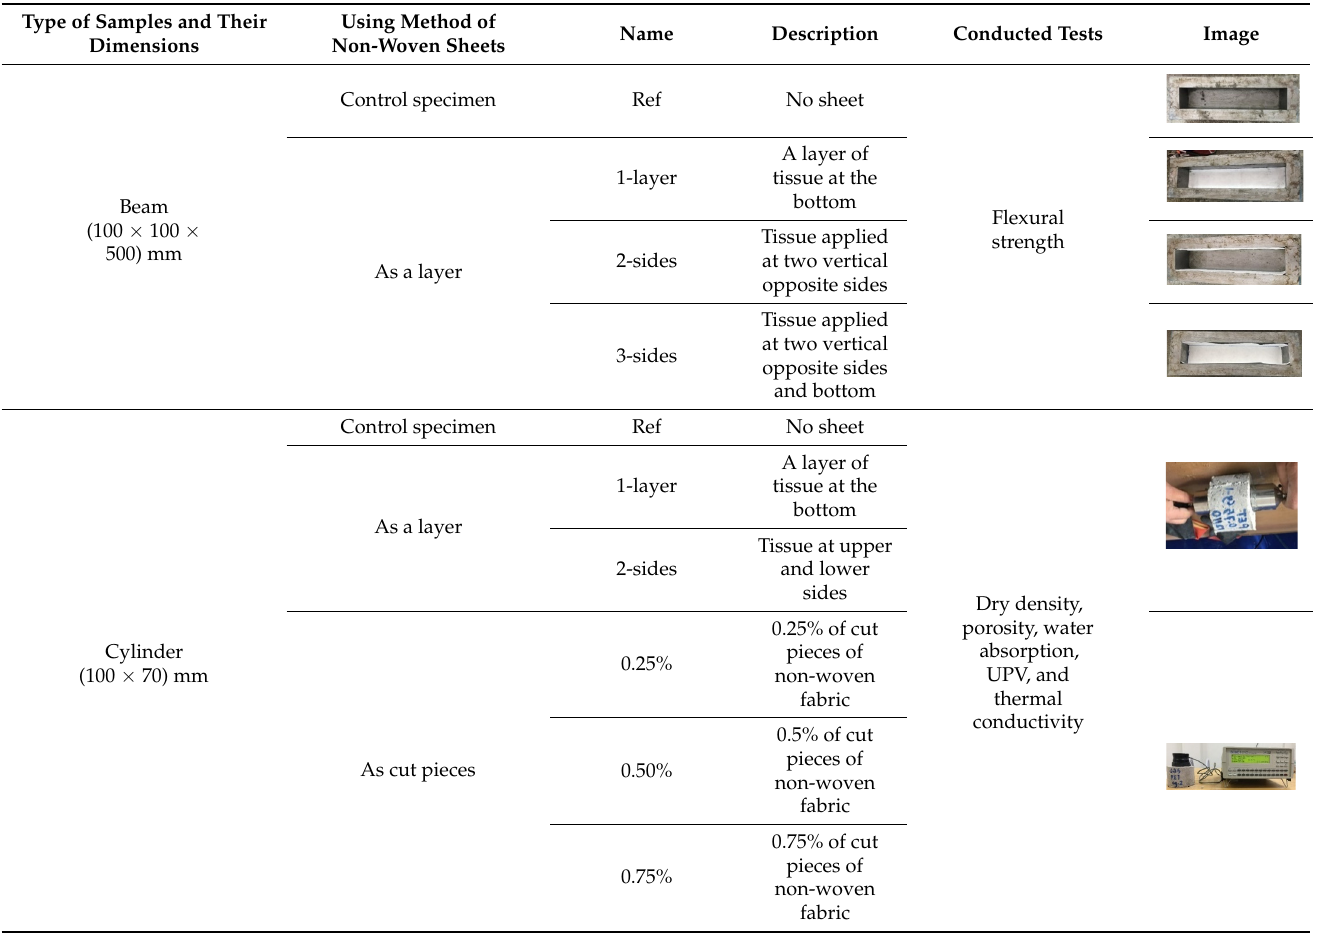
Table 6. The significance criteria for various properties of concrete.